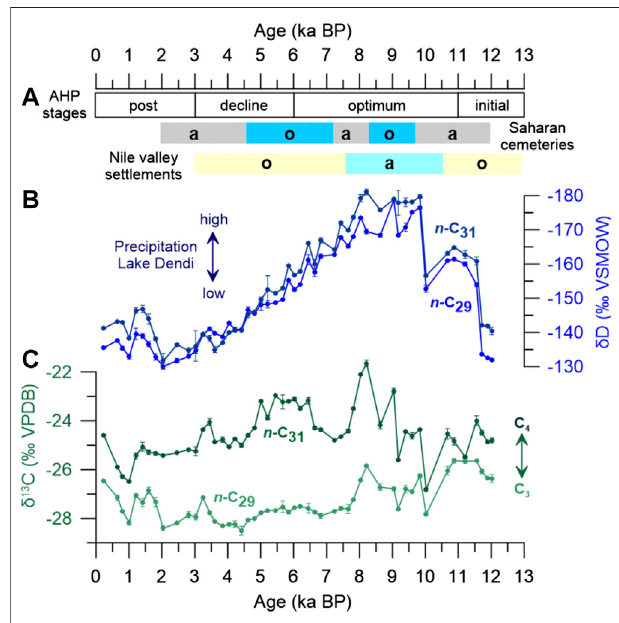
FIGURE 3 | Timing of the stages of the African Humid Period (AHP) based on paleohydrological records in northern Africa (10 – 25 ° N; Lézine et al., 2011a). Archaeological evidence for prehistoric human occupation of the Sahara (paleolake Gobero, Niger; Sereno et al., 2008) and the Nile valley (Kuper and Kröpelin, 2006; Weldeab et al., 2014). (A) Colored bars indicate phases of occupation (o) and abandonment (a), blue colours indicate humid phases. (B) δ D values of the n-C 29 (light blue) and n-C 31 (dark blue) homologues from Lake Dendi sediment core. (C) δ 13 C values of the n-C 29 (light green) and n-C 31 (dark green) homologues from Lake Dendi sediment core. Error bars represent analytical